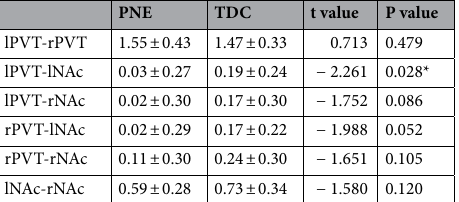
Table 3. The comparison of the FCs of bilateral PVT and NAc between PNE and TD children. *Meant there was statistical significant